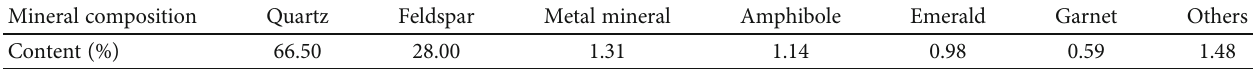
Table 1: Mineralogy of the test sand.